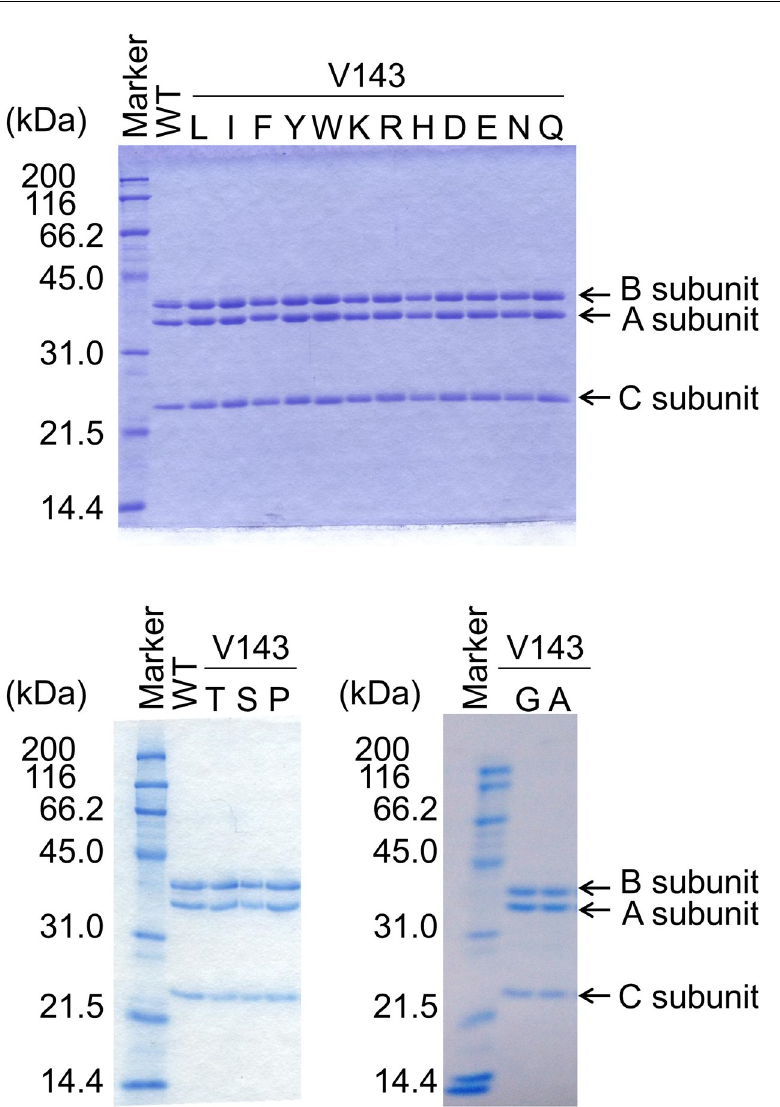
Fig 3. SDS-PAGE of Val143 variants under reducing conditions. Coomassie Brilliant Blue-stained 12.5% SDS- polyacrylamide gel showing marker proteins (Protein Markers for SDS-PAGE, Nacalai Tesque) and purified enzyme preparations of WT and 17 Val143 variants. The original gels are shown in S4